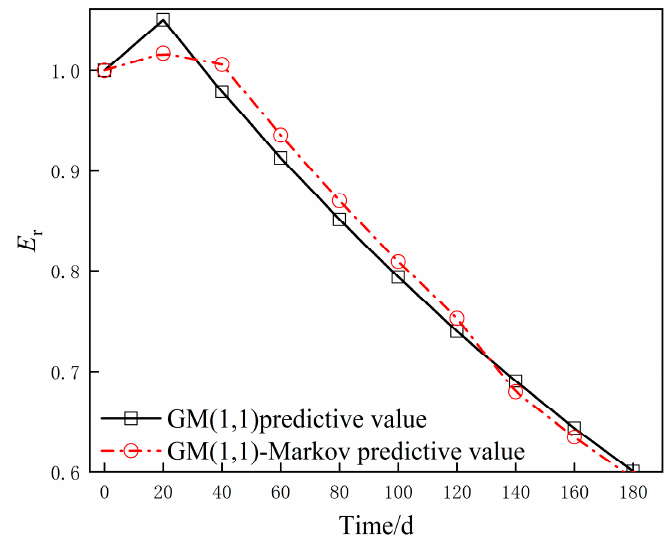
Figure 10. Model prediction comparison.